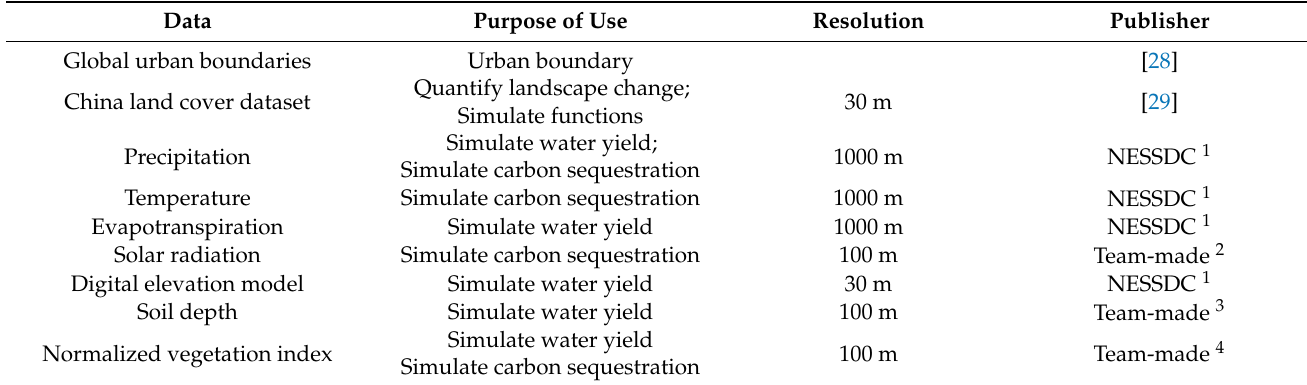
Table 1. Data used in this